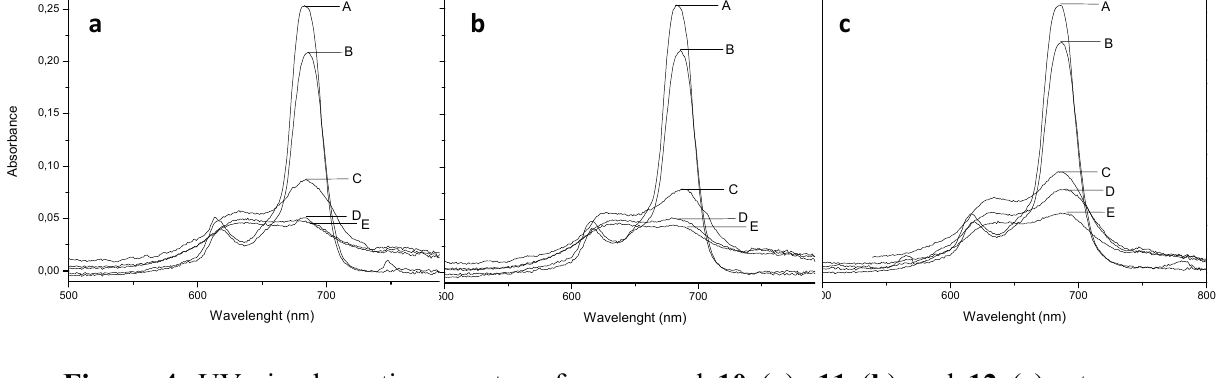
Figure 4. UV-vis absorption spectra of compound 10 ( a ); 11 ( b ) and 12 ( c ), at same concentration, in media with different proportions of DMSO and water (DMSO:water 100:0 (A), 80:20 (B), 60:40 (C), 40:60 (D) and 20:80